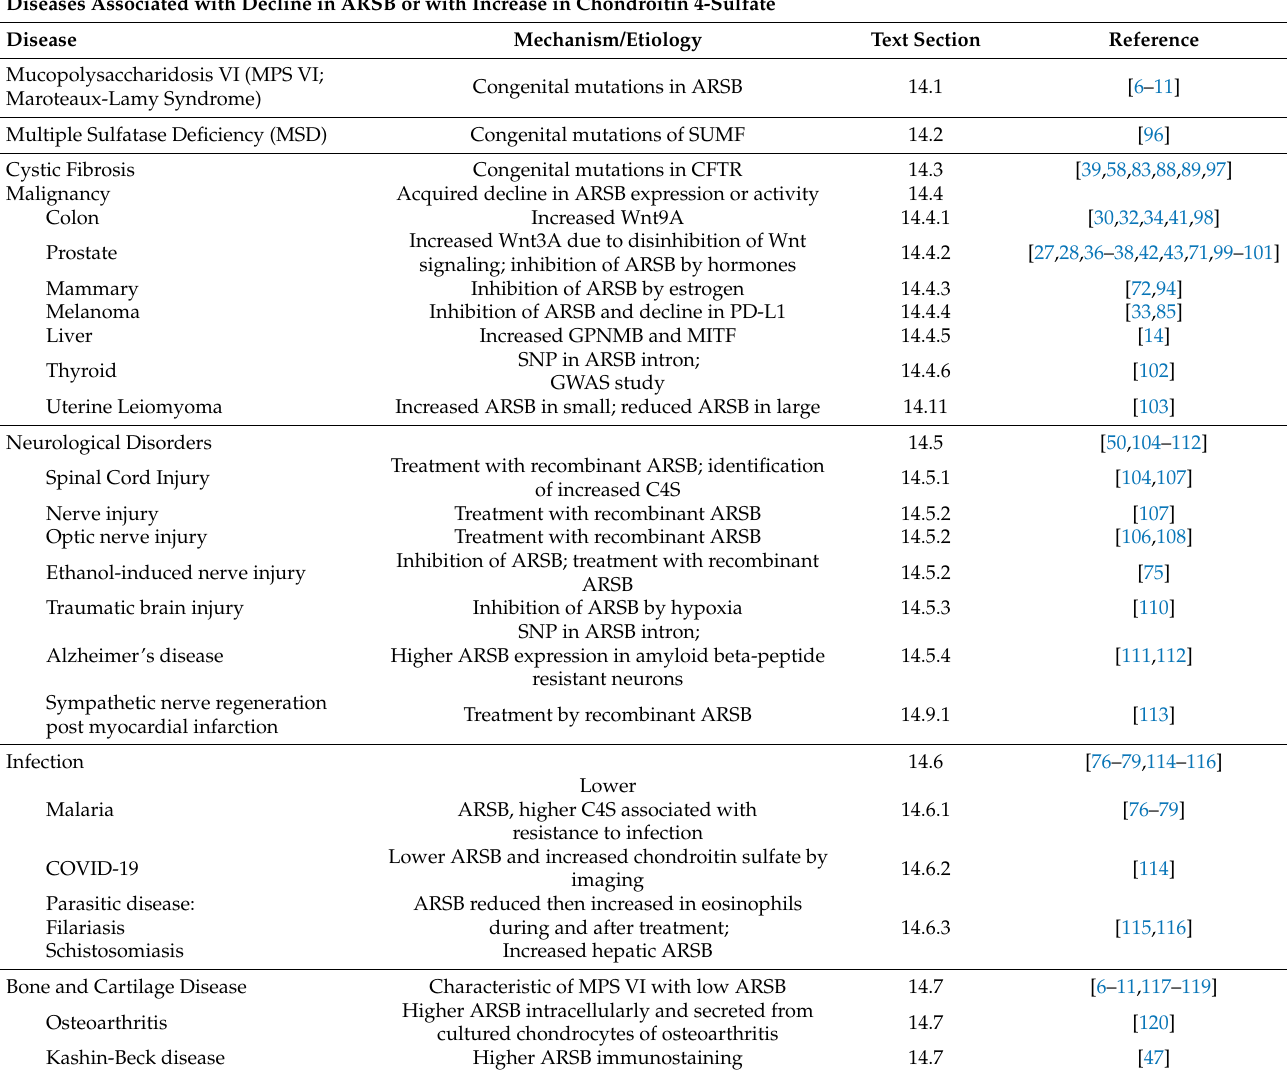
Table 3. Diseases with known association with ARSB or with chondroitin 4-sulfate are presented. Some reports present data about chondroitin 4-sulfate without ARSB